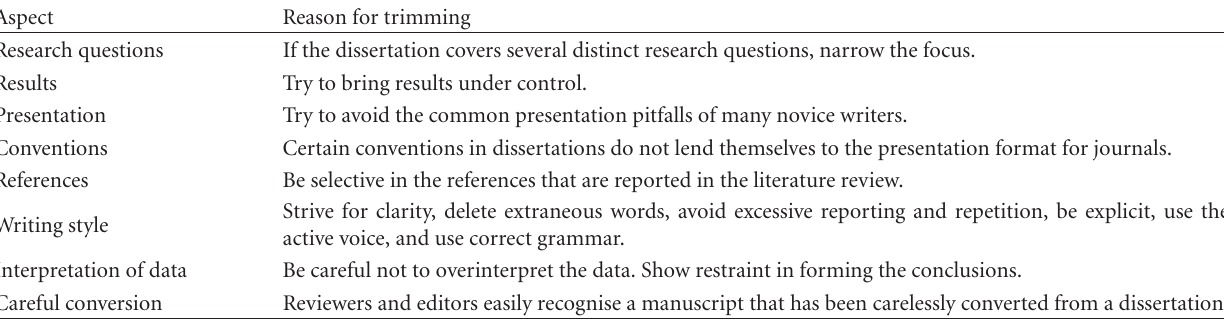
Table 7: Trimming the length.